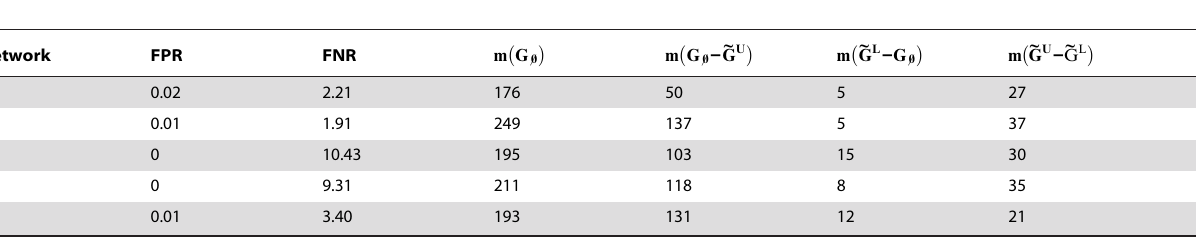
Table 6. Ensemble inference of DREAM4 100-gene gold standard networks: single- and double-gene KO dataset.